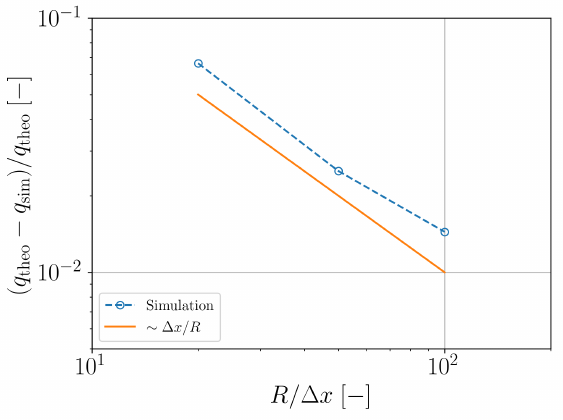
Figure 24. Relative error of the numerically predicted heat flux in a rod as a function of the spa- tial